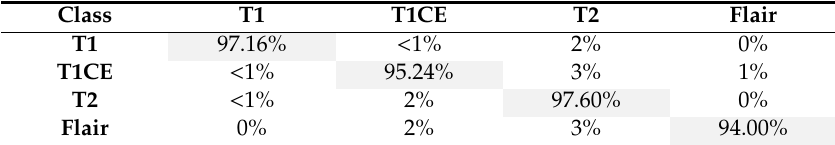
Table 3. Confusion matrix of ELM using Pro-FC7 approach for the BraTS 2017 dataset.